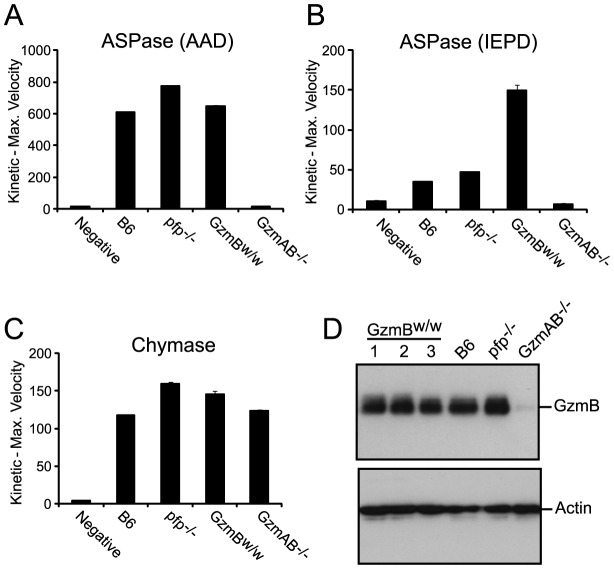
Granule enzyme activity and GzmB expression in T cell lysates from GzmBW/W and GzmBP/P mice.(A) GzmB (ASPase) activity was measured as the maximum rate of cleavage of the peptide thioester substrate Boc-Ala-Ala-Asp (AAD)-SBzl or (B) the activity detected through cleavage of Ac-IEPD-pNA. (C) Chymotrypsin-like (chymase) activity (cleavage of Suc-Phe-Leu-Phe SBzl) was used as an independent measure of granule enzyme activity. The data points show the mean ± SEM of triplicate readings. The data is representative of 3 individual experiments. Equivalent results were obtained with lysates generated from IL-2 activated NK cells. (D) Western blot analysis for GzmB expression in OT1 T cells from outbred w/w mice, B6 and control GKO (B6.Pfp−/− and B6.GzmAB−/−) mice. The blot was re-probed for actin expression.